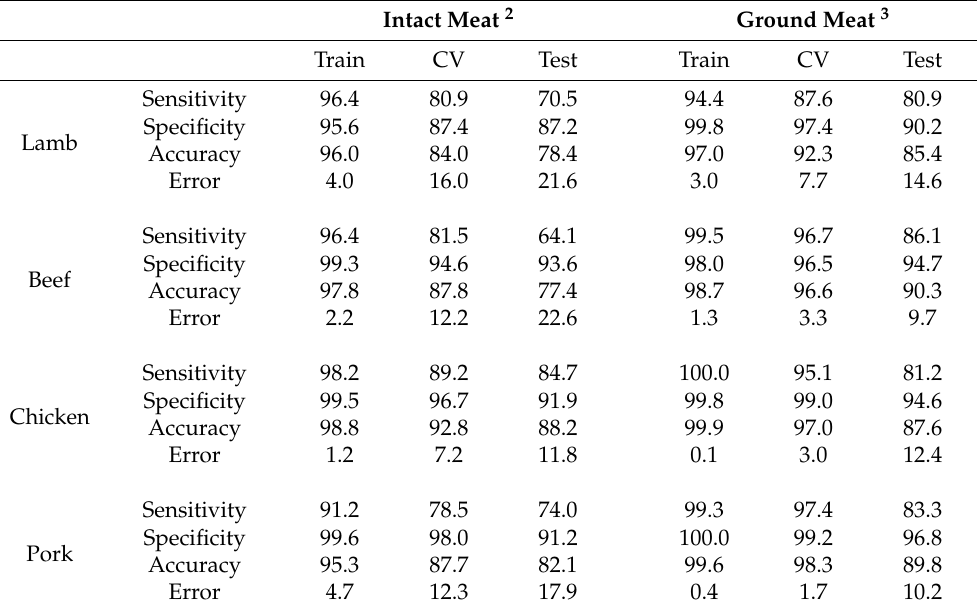
Table 4. Classification performance (in %) of SVM (RBF kernel) model 1 for classification of lamb, beef, chicken and pork using six individual spectra of each sample for the NIR sensor. Intact Meat